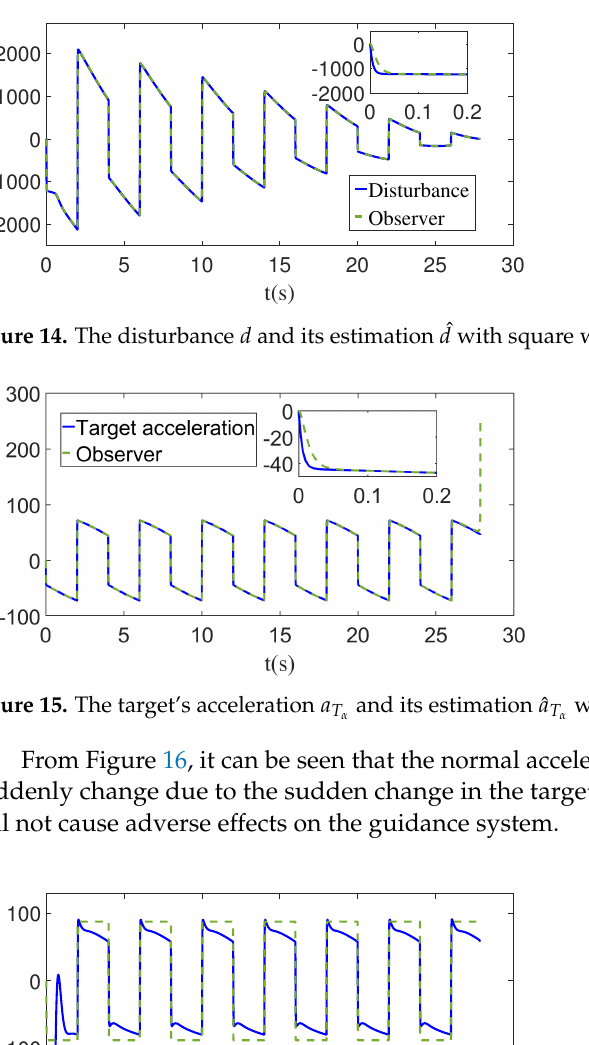
Figure 16. The normal acceleration of the missile a M and the target a T with square wave